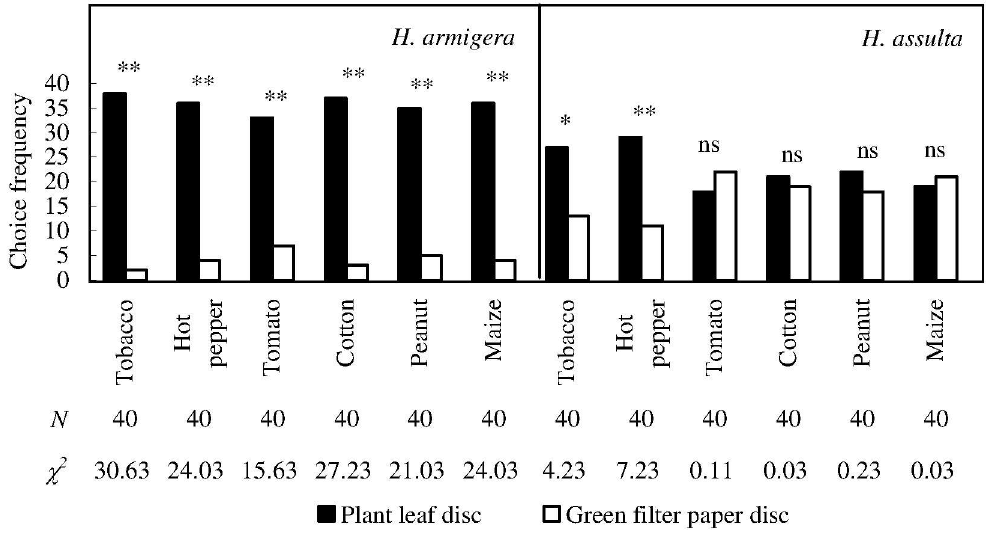
Fig 5. Choice responses of H . armigera and H . assulta larvae under the conditions of each plant leaf disc paired with green filter paper disc. “ * ” and “ ** ” indicate significantdifference within group at P = 0.05 and P = 0.01 levels, respectively,and “ns” indicates no significantdifference within group, accordingto chi-squaretest. The values of “ N ” and “ χ 2 ” beneathrespectivebars indicatenumber of test insects and statistical χ 2 values,